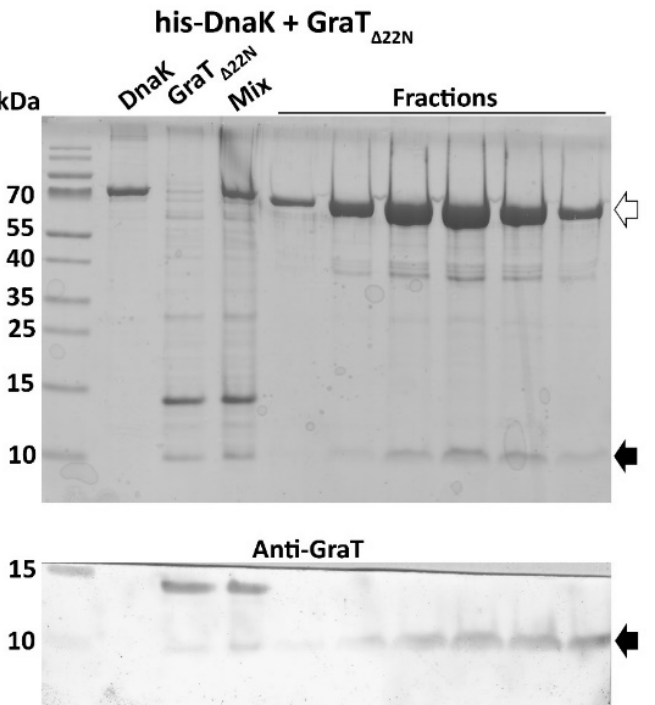
Figure 4. DnaK binds to N -terminally truncated GraT. His 6 -DnaK pulls down the N -terminally trun- cated toxin GraT ∆ 22N from the cell lysate (Mix) prepared by mixing two E. coli cultures overexpressing either His 6 -DnaK (DnaK) or GraT ∆ 22N . Upper panel shows the Coomassie-stained lysates (DnaK, GraT ∆ 22N , Mix) and elution fractions from the Ni 2+ affinity column resolved by SDS-PAGE. Lower panel represents the Western blot analysis of an identical gel with anti-GraT antibodies. His 6 -DnaK and GraT ∆ 22N are indicated by the empty and solid arrows, respectively. The finding that the conserved C -terminal motif in DnaK plays an important role in supporting GraT toxicity prompted us to study other fitness effects that the DnaK C - terminus might have in P. putida . First, the growth of the wild-type and dnaK mut4 strain was compared at different temperatures. Given that growth curves of two strains revealed no clear differences in any tested temperatures (Figure 5A), the substitution mutations in the DnaK C -terminus seem not to significantly influence the growth and thermotolerance of P. putida . To control whether temperatures higher than 30 ◦ C can trigger the heat shock response, the activation of the σ 32 -dependent P ibpfxs promoter was analyzed. Data show that transcription from P ibpfxs was upregulated already at 34 ◦ C and even more at 38 ◦ C (Supplementary Figure S1). Thus, despite the unaffected growth (Figure 5A), these temperatures do represent heat stress to P. putida